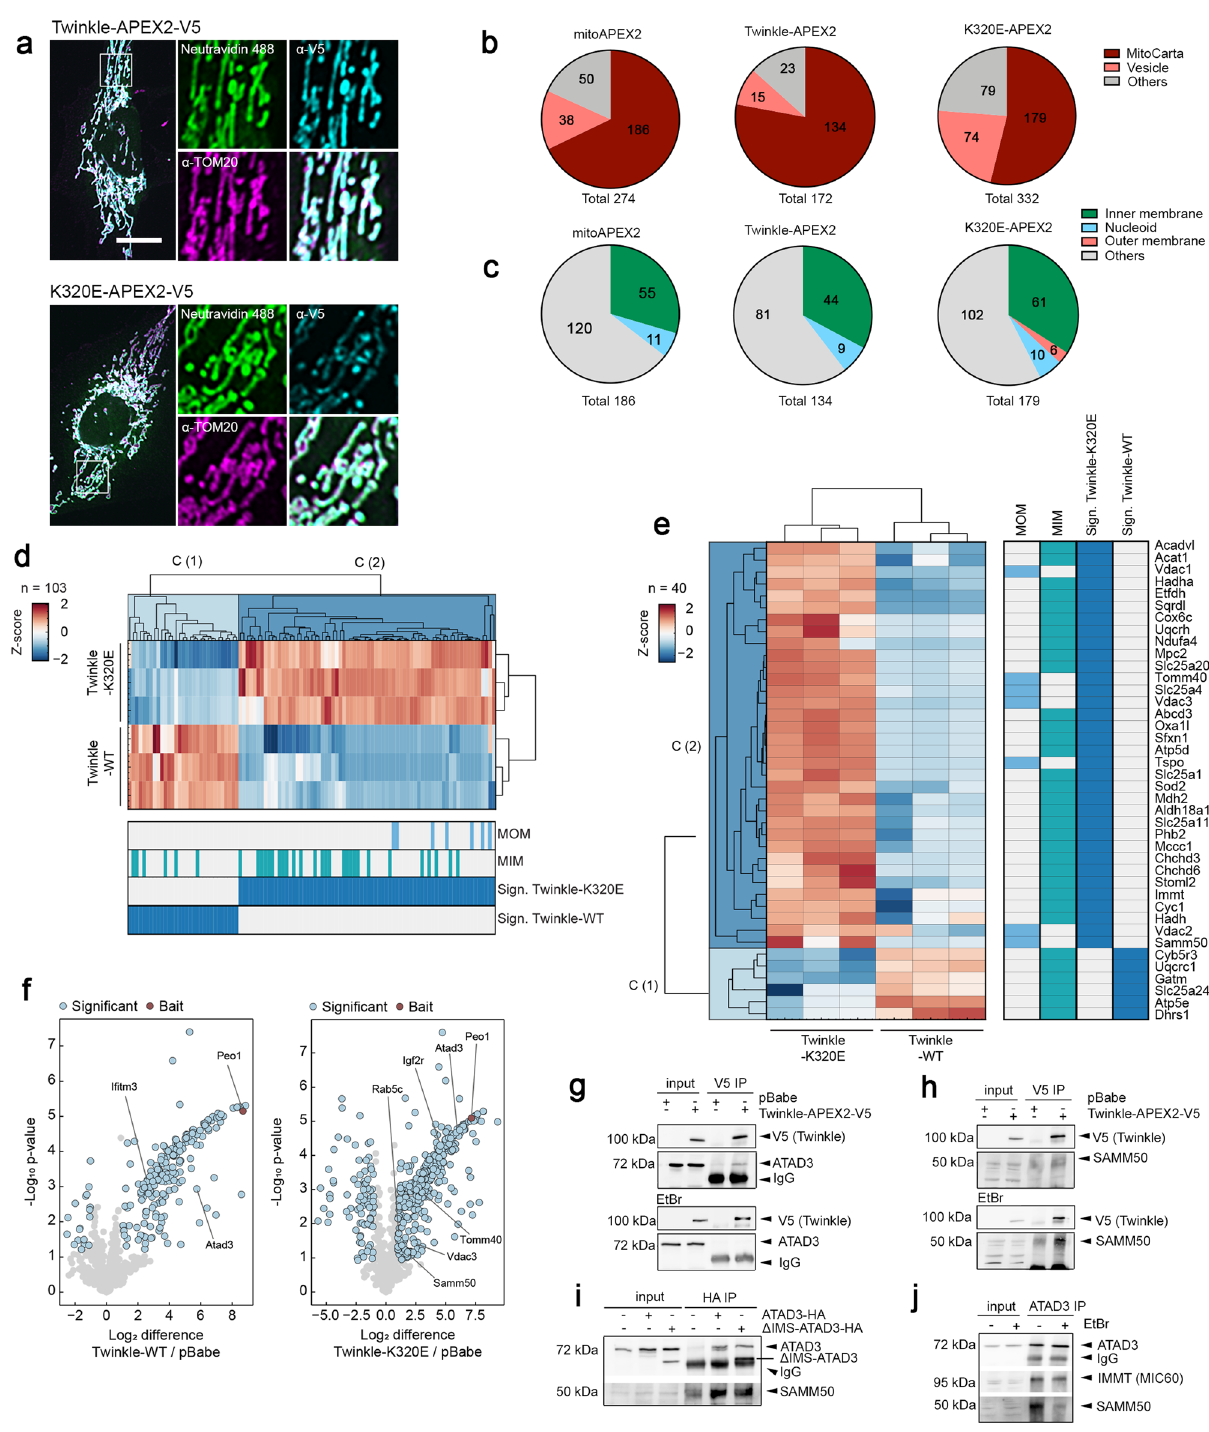
Fig. 4 | Mitochondrial membranes reorganize upon mtDNA damage. a Immuno fl uorescence of C2C12 cells expressing Twinkle-APEX2-V5 variants exposed to biotin-phenolcrosslinking. Biotinylated proteins weredetected with α - Neutravidin, mitochondria with α -TOM20 and α -V5 for Twinkle. Scale bar 10 µ m. b Pie charts of signi fi cant hits detected by MS after biotin-phenol crosslink (sig- ni fi cance= q- value <0.05 and absolute log2 difference >1). Groups were created accordingtoMitoCartaandGOCCannotation. c Piechartsshowingallsigni fi cantly enrichedMitoCartaannotatedproteinsandtheirmitochondrialsub-compartment. d Hierarchical clustering of Z-score-normalized protein targets. Enrichment of proteins annotated in MitoCarta and, e with proteins previously described to be located in the mitochondria inner (MIM) or outer membrane (MOM) for